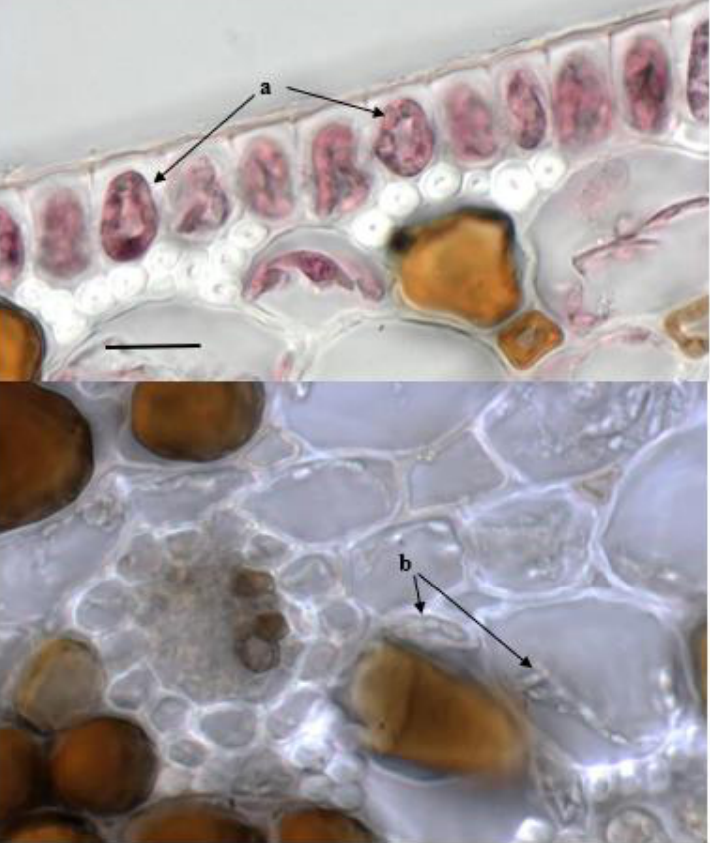
Figure 4. Section of leaves of P. oceanica from Sciacca: hyphae in epidermal (red-stained, (a)) and in mesophyll (not stained, (b)) cells. Bar = 20 µm.